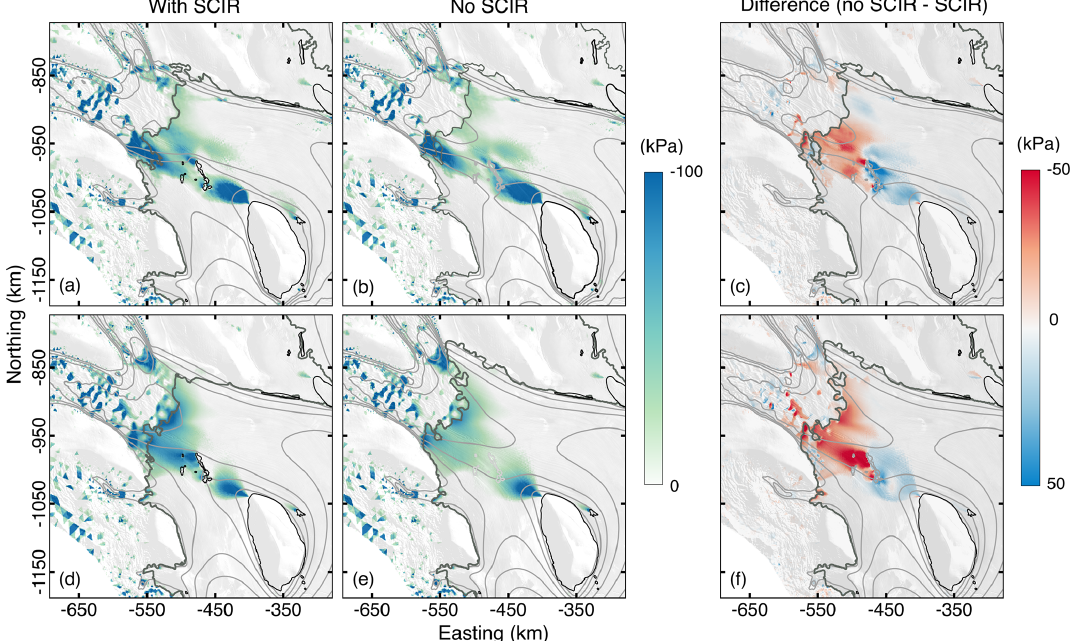
Figure 6. The longitudinal compressive stress − R ll acting on the RIS and tributary ice streams with and without the SCIR. In panels (a) – (c) , the simulation is initialised with B inv . In panels (d) – (f) , the simulation is initialised with B u